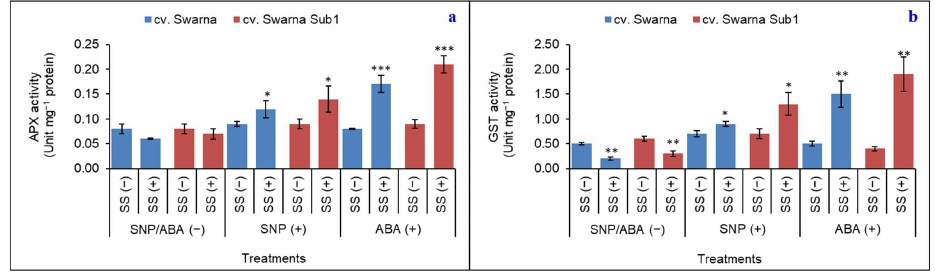
Figure 9. Changes in ascorbate peroxidase ( a ) and glutathione S -transferase ( b ) activity in two rice genotypes (cv. Swarna and Swarna Sub1) under salinity stress [SS (+)] and non-salinity stress [SS ( − )] for 72 h with [SNP (+) or ABA (+)] or without [SNP/ABA ( − )] priming for 24 h. Data are presented in bars with mean ± SE ( n = 3) from independent experimental sets and the significant values are represented as * ( p ≤ 0.05), ** ( p ≤ 0.01) and *** ( p ≤ 0.001) by student’s t -test to denote the significant difference between SS ( − ) and SS (+) of SNP/ABA ( − ) as well as SNP (+) and ABA (+) of each rice genotype.